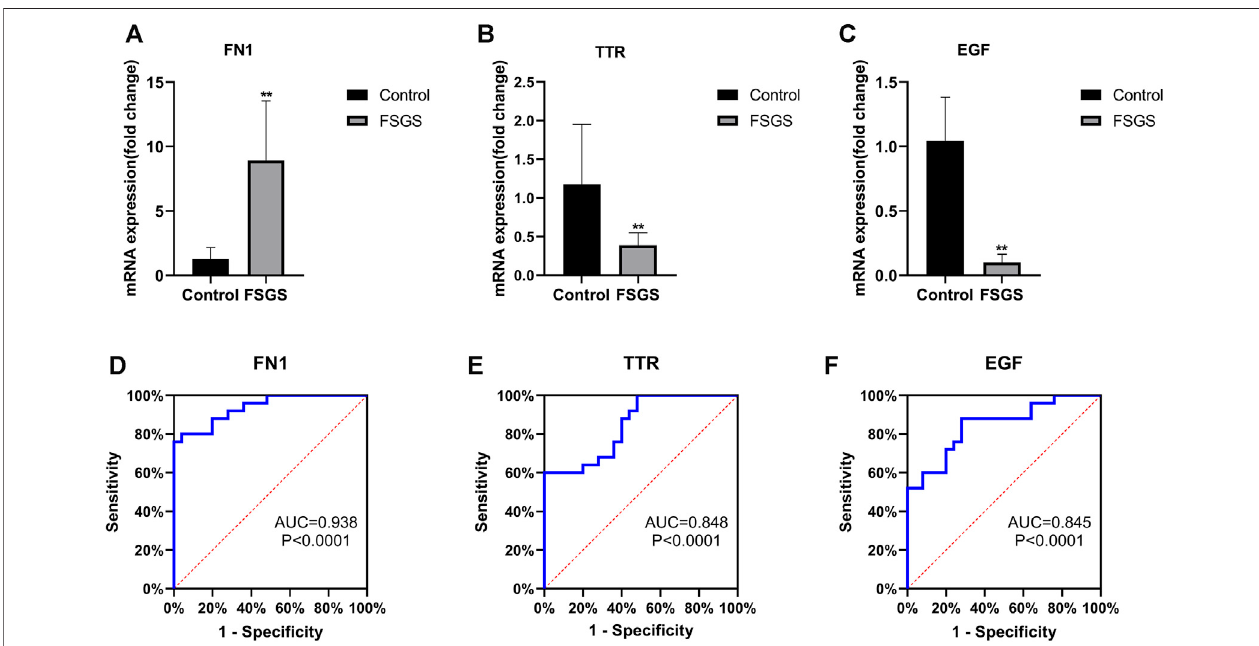
FIGURE 5 | Quantitative real-time PCR of FN1 (A) , TTR (B) and EGF (C) in the FSGS rat model compared to the control. ROC curve analysis of FN1 (D) , TTR (E) and EGF (F) for predicting FSGS. Data are expressed as the mean ± SEM; ** p < 0.01 vs the control group. The areas under the curves (AUCs) were 0.938 (95% CI: 0.876 – 1.000, p < 0.0001)forFN1(D),0.848(95%CI:0.744 – 0.952, p < 0.0001)forTTR (E) ,and0.845(95%CI:0.737 – 0.953, p < 0.0001)forEGF (F) .Abbreviations:CI, con fi dence interval; ROC, receiver operating